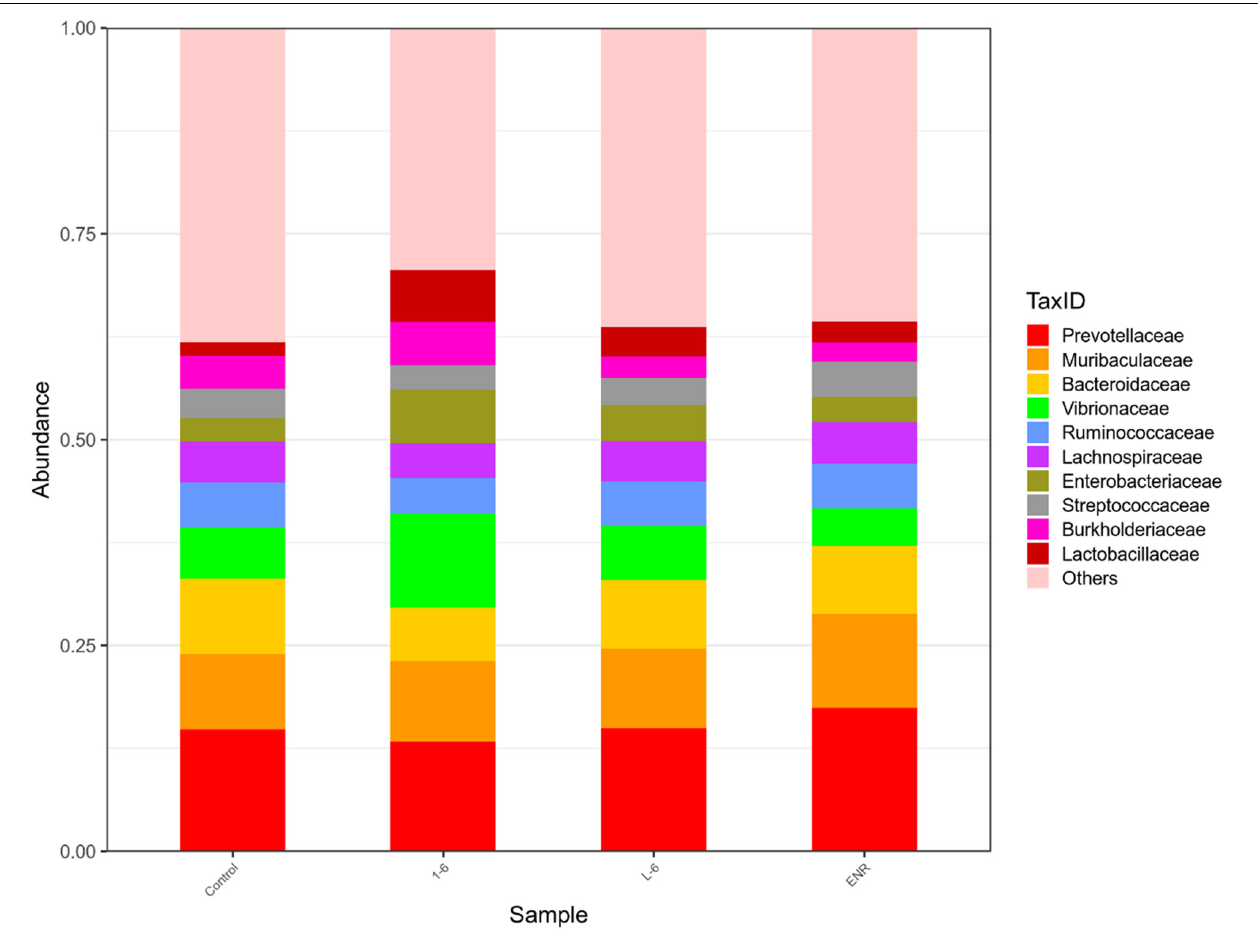
FIGURE 13 | Structure and composition of intestinal microflora of Sebastes schlegelii at family level. The relative abundance of Prevotellaceae , Muribaculaceae , Bacteroidaceae , Lactobacillaceae , and Streptococcaceae in the control group were 14.84, 9.1, 9.1, 1.7, and 3.5%, respectively. The relative abundance of Prevotellaceae , Bacteroidaceae , and Lactobacillaceae in 1–6 groups were 13.44, 6.63, and 5.64%, respectively. The relative abundance of Lactobacillaceae in L-6 group was 3.57%. The relative abundance of Prevotellaceae , Streptococcaceae , and Muribaculaceae in enrofloxacin group were 17.41, 4.32, and 11.36%,